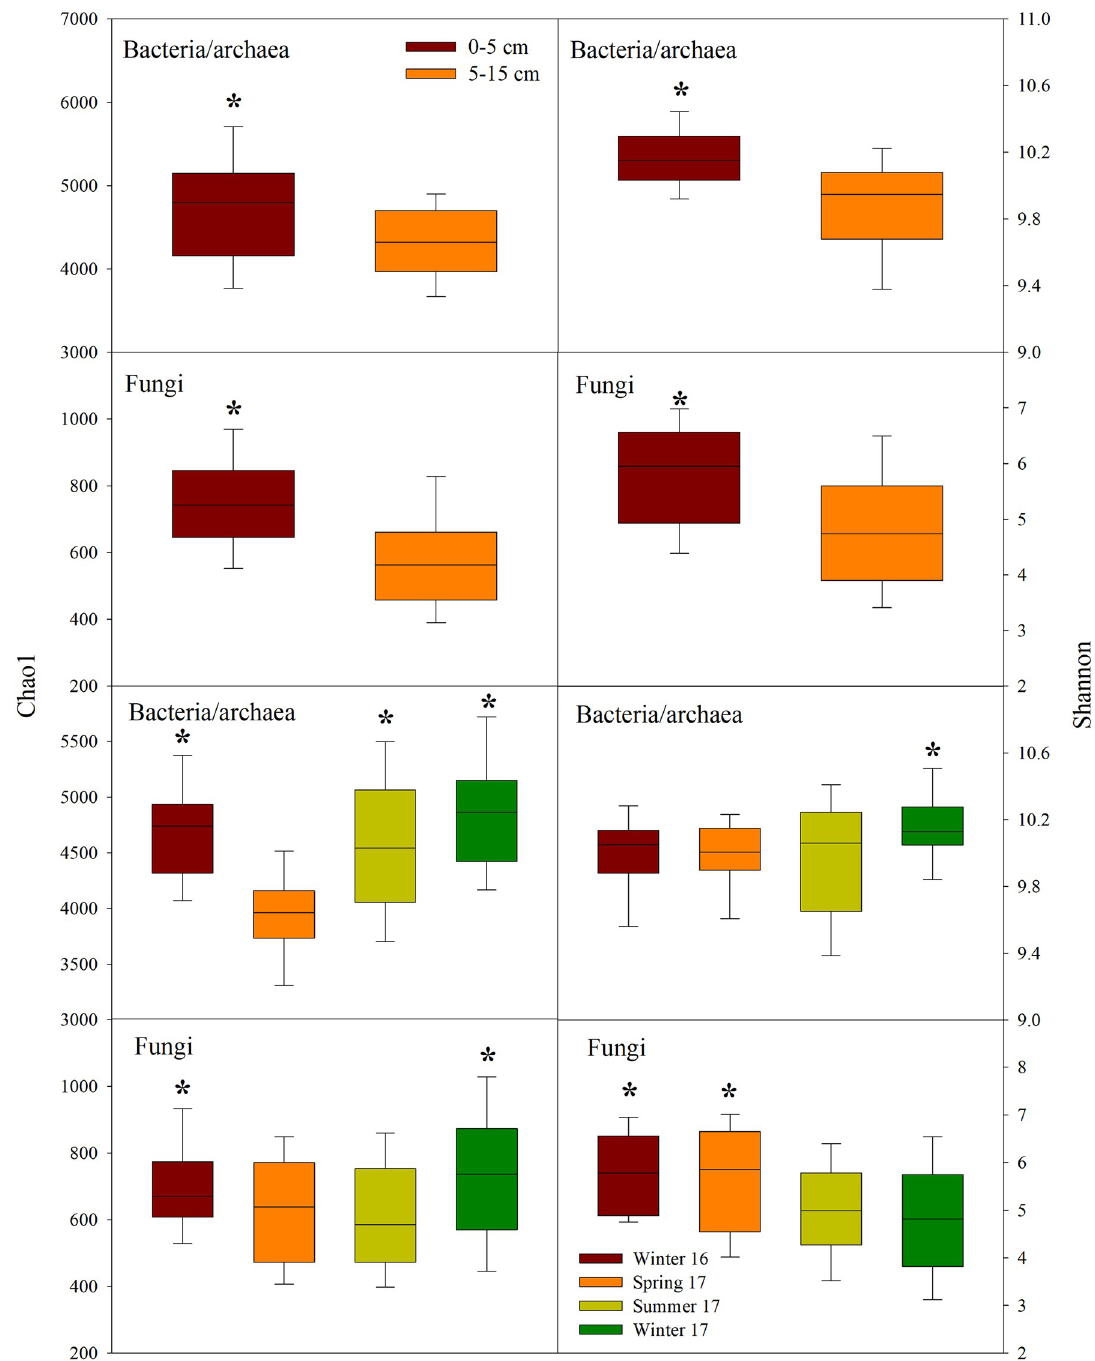
Fig 3. Box plots showing Chao1 richness and Shannon diversity of bacterial/archaeal and fungal communities affected by two soil depths (0–5 and 5–15 cm) and four sampling seasons (Winter 2016, Spring, Summer, and Fall 2017). Sequence depths were 10000 for 16S and 5000 for ITS. Asterisks indicate significant difference at α = 0.05 between two soil depths or among four sampling seasons.